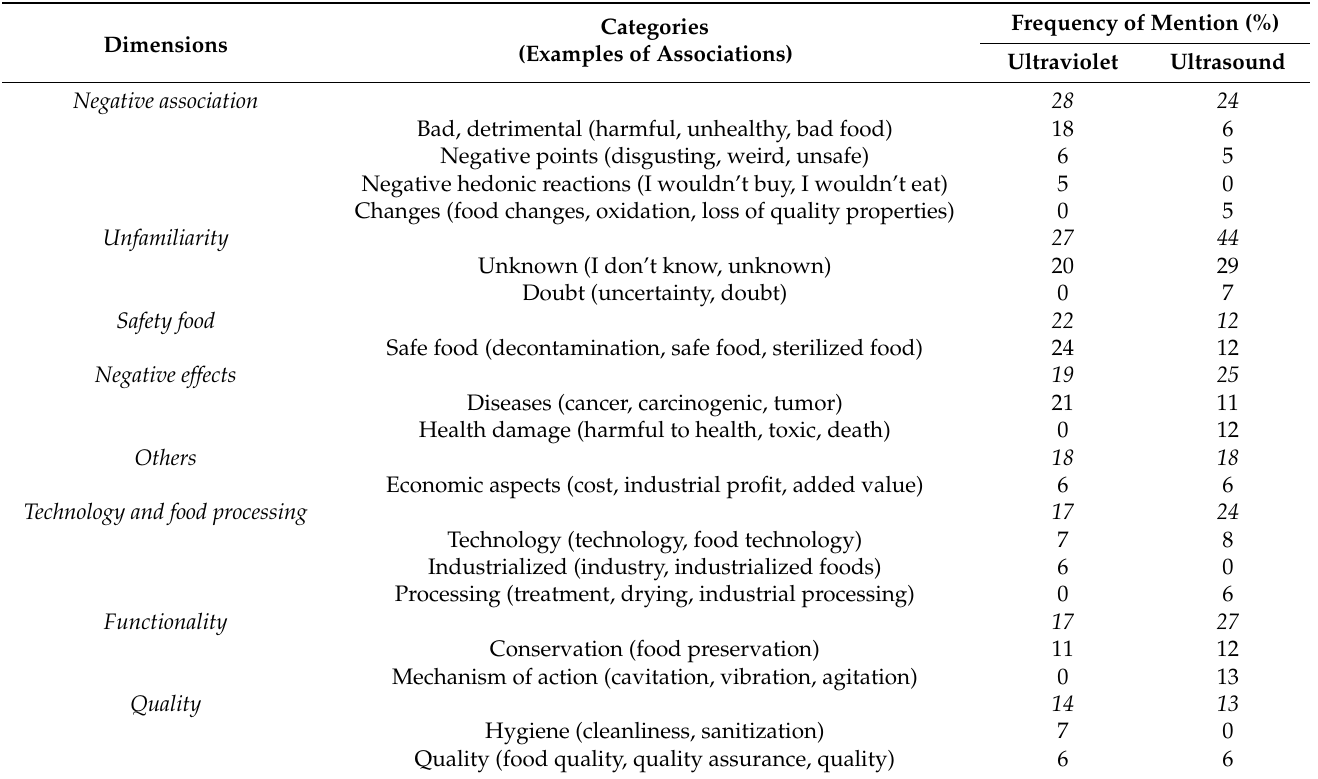
Table 2. Frequency of mention of the dimensions, categories, and examples of individual associations identified in the word association task about food processed by ultraviolet radiation and